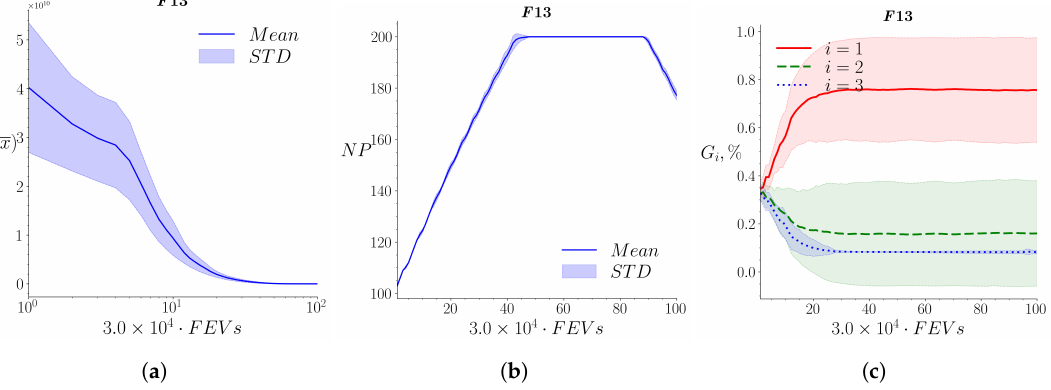
Figure A13. The dynamics of COSACC-LS1 on the F13 problem: ( a ) Convergence; ( b ) Population size; ( c ) Redistribution of